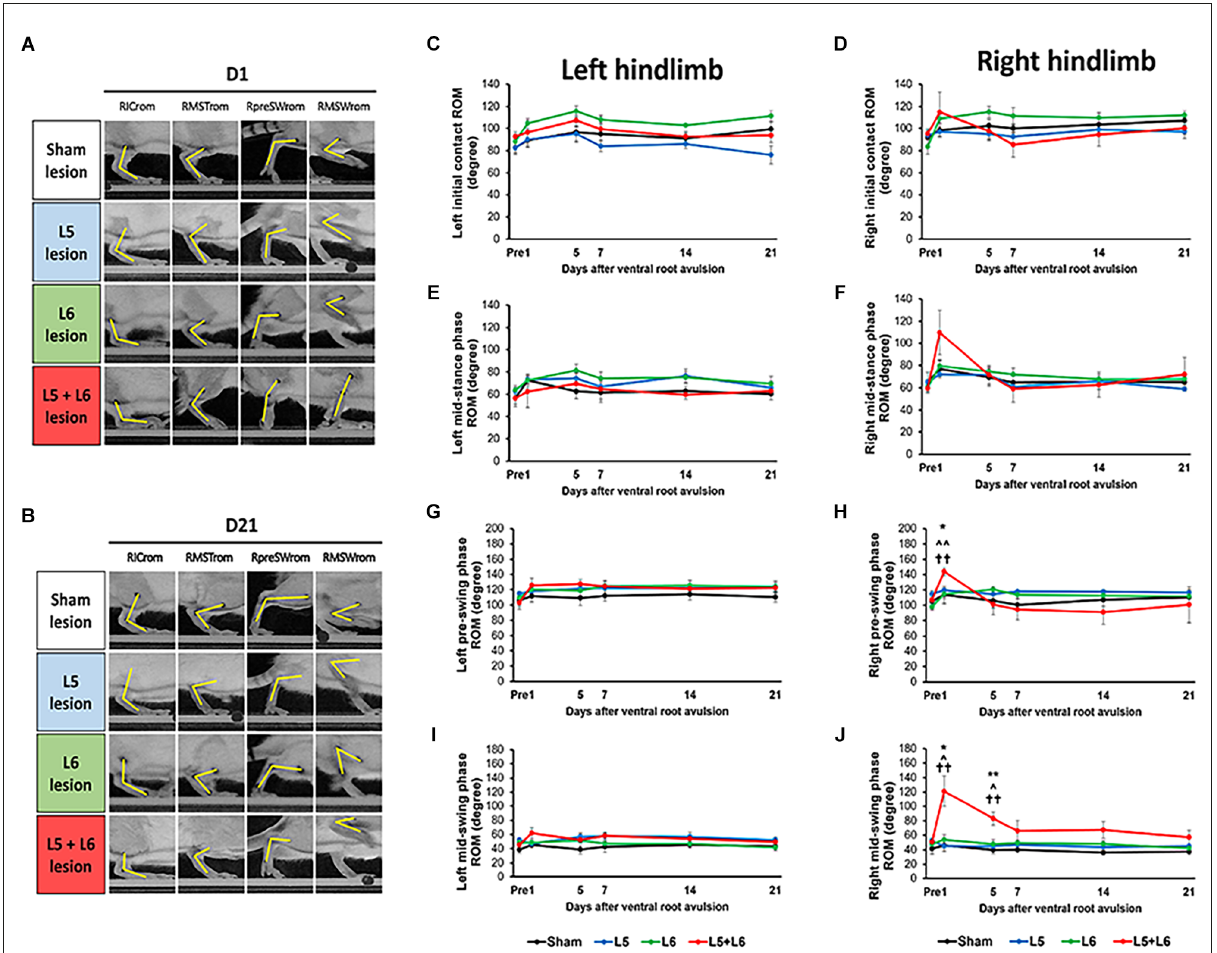
FIGURE2 Characteristics of stepping of rats (as indicated by kinematic joint angle). Ankle joint angles were obtained from the sagittal view and determined from the landmarks on the knee, ankle, and 5th metatarsal head. Photographs of each group of rats in right initial contact ROM (RICrom), right mid-stance ROM (RMSTrom), right pre-swing ROM (RpreSWrom), and right mid-swing ROM (RMSWrom) on the 1st day (A) and 21st day (B) post-lesion. Time-course changes in ROM of the ankle joint in the left (C) and right (D) hindlimb at initial contact, left (E) and right (F) hindlimb at mid-stance phase, left (G) and right (H) hindlimb at pre-swing phase, left (I) and right (J) hindlimb at mid-swing phase. Note the significant increase in ROM in both the pre- and mid-swing phases after L5 + L6 ventral root avulsion at Day 1 post-lesion. Error bar = SEM. * p < 0.05, ** p < 0.01 significant differences are shown between the sham and L5 + L6 groups. ∧ p < 0.05, ∧∧ p < 0.01 indicate significant post hoc Fisher’s LSD differences when compared between L5 lesions and L5 + L6 lesions. †† p < 0.01 indicates significant post hoc differences between the L6 lesion and the L5 + L6 lesion